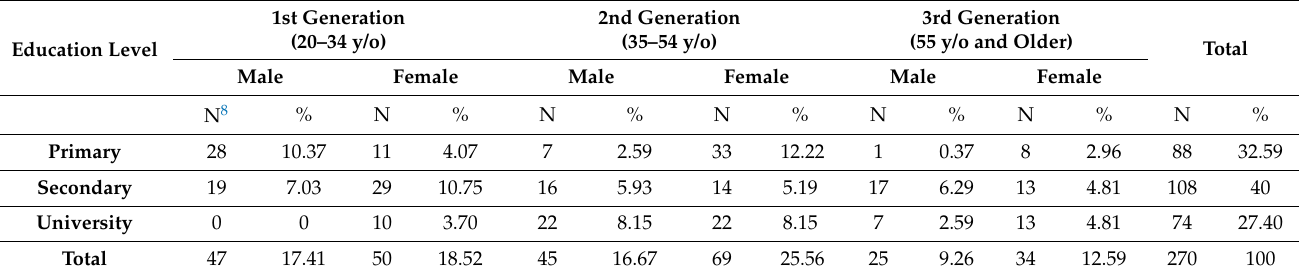
Table 2. Distribution of the frequencies of vamos according to social factors such as age, gender, and social status.